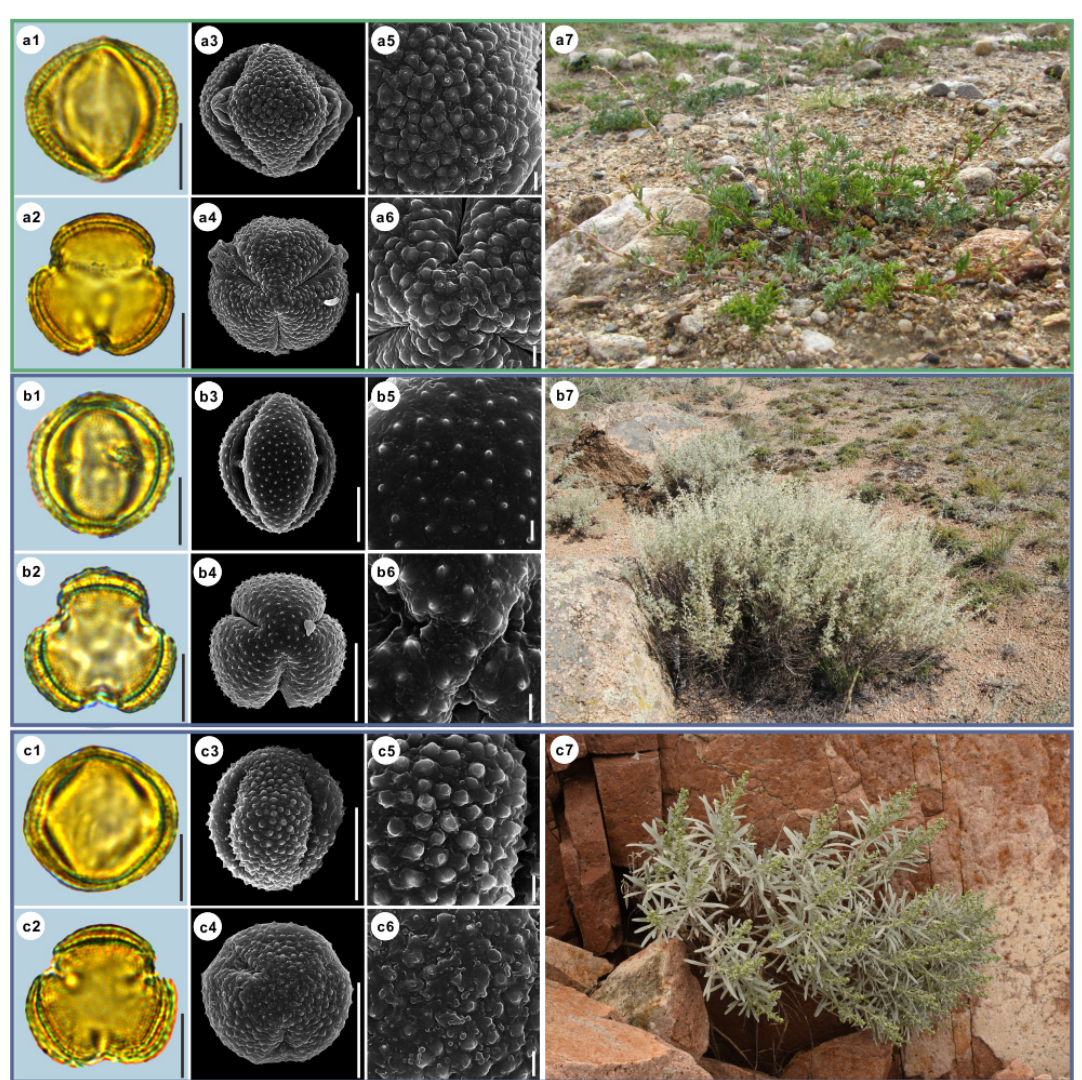
Figure 6. Pollen grains and the habitats of their source plants. (a) Artemisia roxburghiana ; (b) Artemisia rutifolia ; and (c) Artemisia chinensis . Pollen grains in equatorial view under LM (a1, b1, c1) and SEM (a3, a5, b3, b5, c3, c5) , in polar view under LM (a2, b2, c2) and SEM (a4, a6, b4, b6, c4, c6) , along with the habitats of their source plants (a7 provided by © Bo-Han Jiao, b7 cited from https://www.inaturalist.org/photos/62207191, last access: 19 August 2022, by © Daba, c7 provided by © Jia-Hao Shen ) . Scale bar in LM and SEM overview 10µm, and in SEM close-up